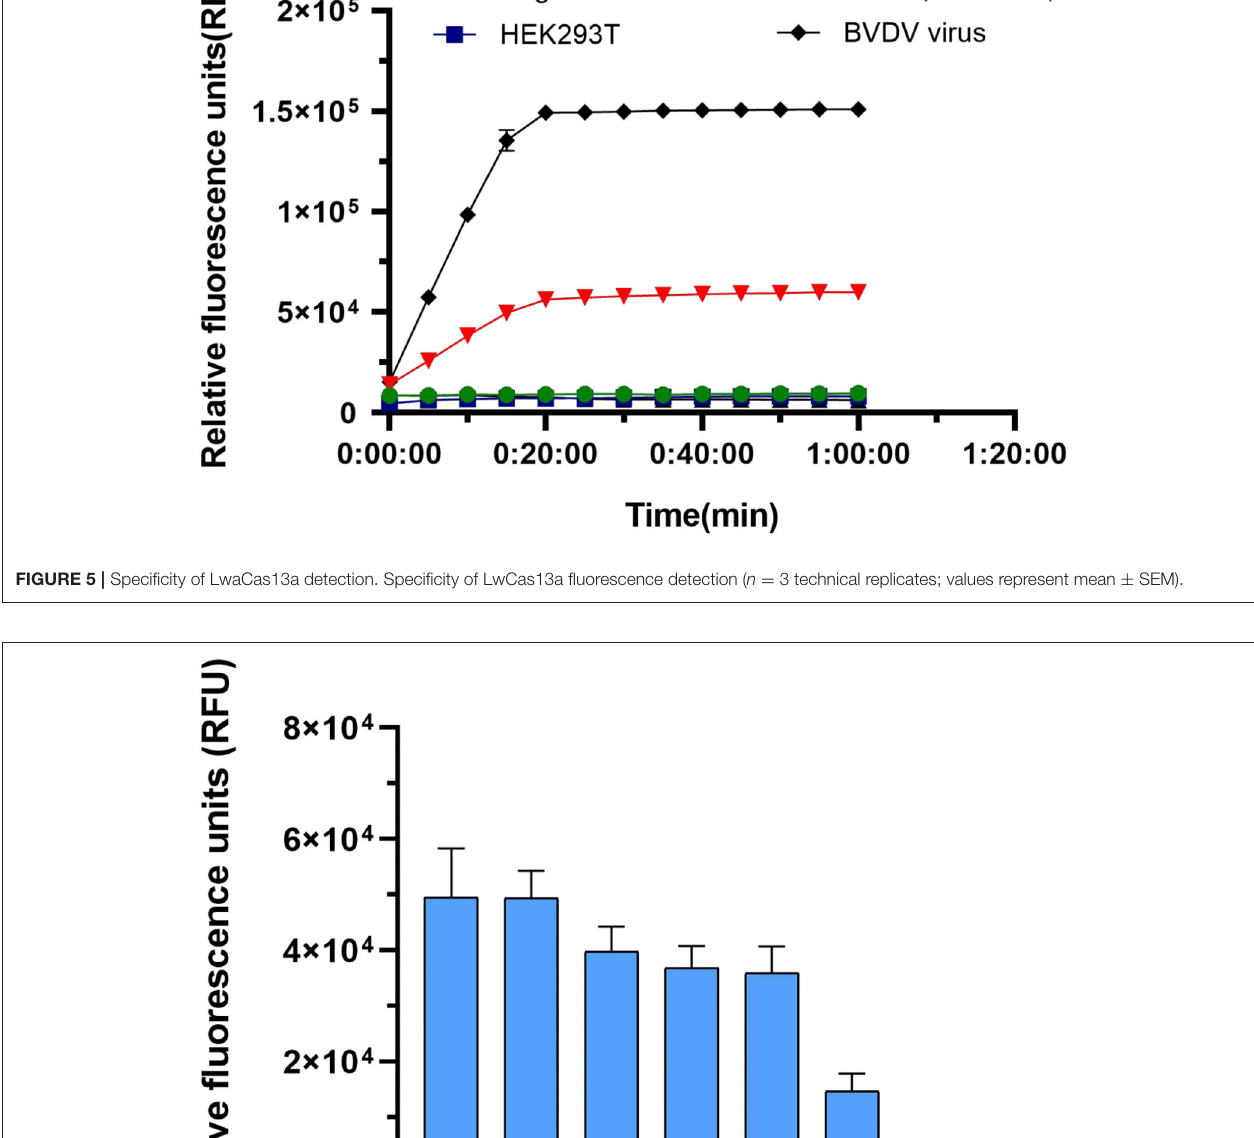
BVDV, we only need to extract the obtained sample’s RNA to directly perform the detection. At present, our system is under further study for detecting animal serum samples